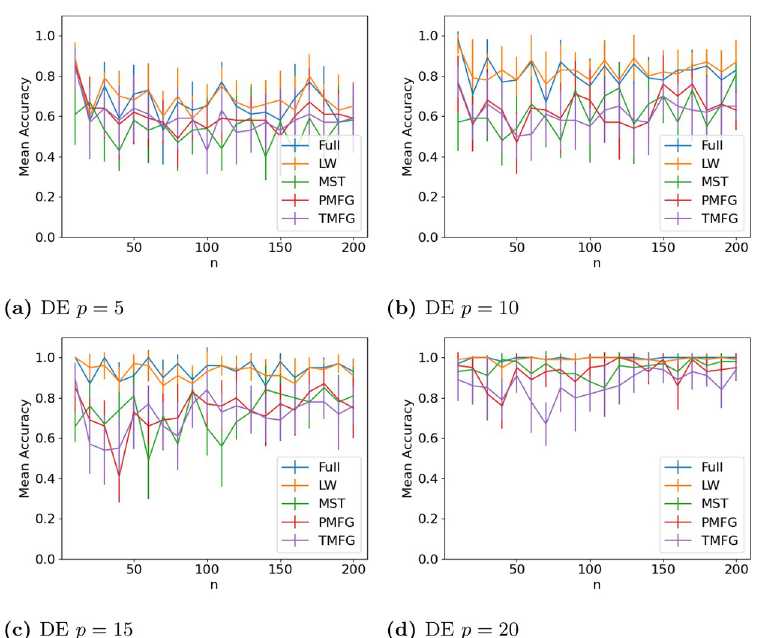
Fig 17. Accuracy when distinguishing between correlation matrices inferred from adjacent time windows based on the median volatility using the SF method and a random forest classifier for German stock returns. (a) DE p = 5, (b) DE p = 10, (c) DE p = 15, (d) DE p = 20.